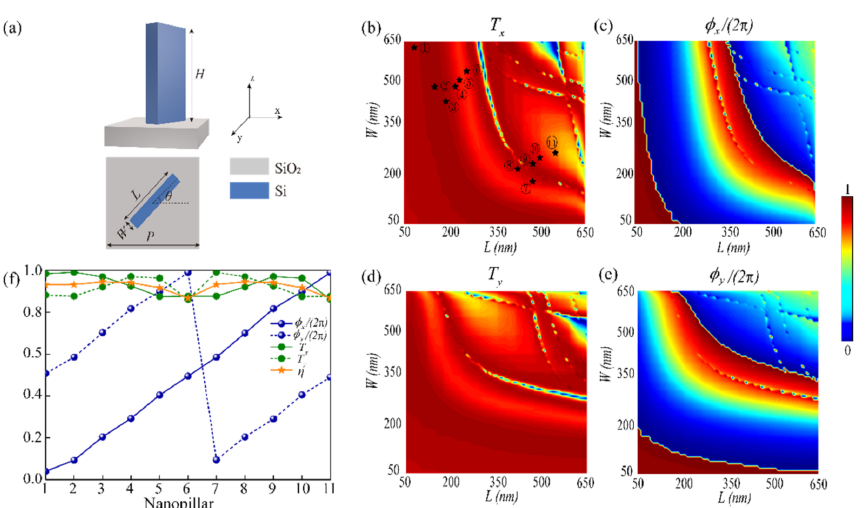
Figure 3. ( a ) Perspective and top views of the meta-atom which consists of a rectangular a-Si nanopillar patterned on the square SiO 2 substrate. ( b , c ) The transmission coefficients and phase shifts for XLP illumination. ( d , e ) The transmission coefficients and phase shifts under YLP incident light. ( f ) The corresponding transmission coefficients, phase shifts, and polarization conversion efficiencies of all selected 11